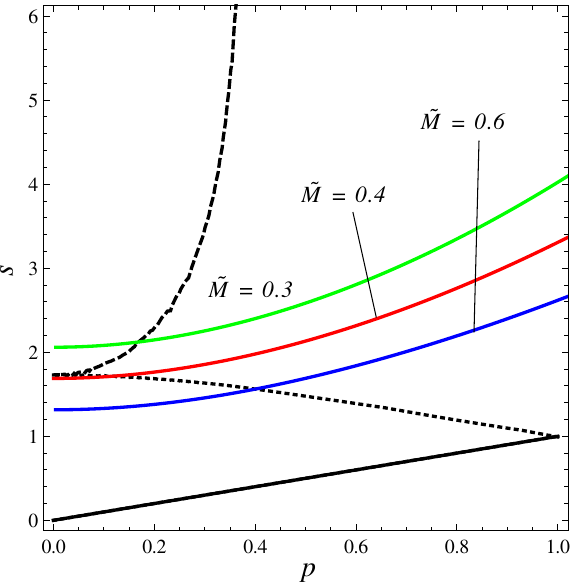
Fig. 18 Plots of M = const. curves for ˜ M = 0 . 3 (green), ˜ M = 0 . 4 (red) and ˜ M = 0 . 6 (blue) on the ( p , s ) plane